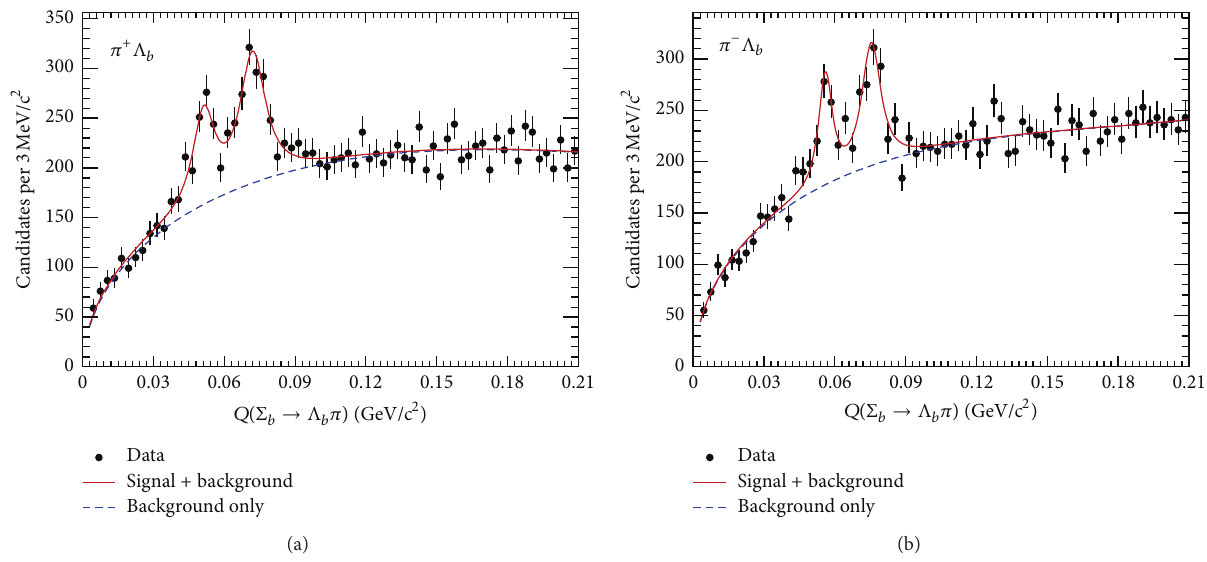
Figure 2: The 𝑄 = 𝑀(Λ 0 𝑏 𝜋 ± ) − 𝑀(Λ 0 𝑏 ) − 𝑚 𝜋 spectrum for candidates with the projection of the corresponding unbinned likelihood fit superimposed, (a) for 𝜋 + Λ 0 𝑏 and (b) for 𝜋 − Λ 0 𝑏 candidates (from [7]).